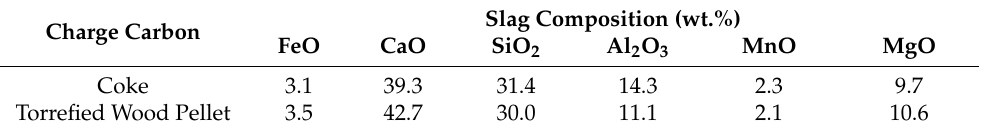
Table 8. Effect of torrefied wood pellets on slag